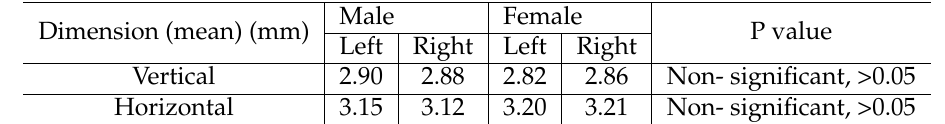
Table 1. Size of mental foramen.